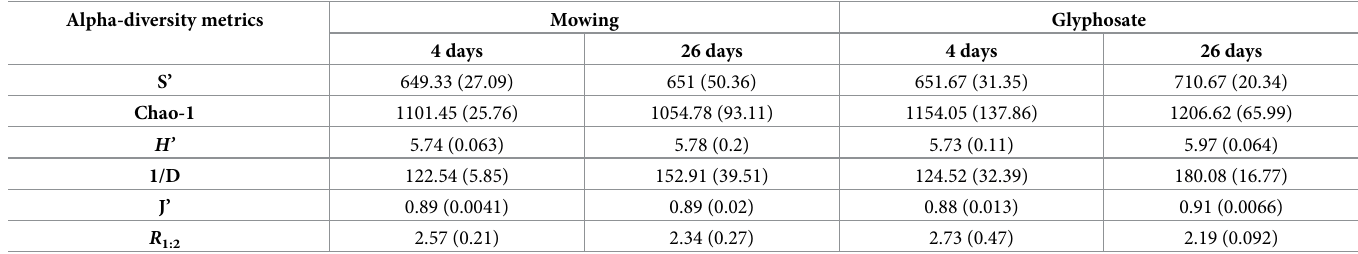
Table 3. Alpha-diversity metrics from the metabarcoding dataset. Mean values are indicated for each treatment. Values between brackets indicate the standard error of the mean (n = 3). S’: observed richness; Chao-1: Chao-1 index (estimated richness); H’ : Shannon index; 1/D: reciprocal of Simpson index; J’: Pielou’s index; R 1 : 2 : Hill-ratio. Alpha-diversity